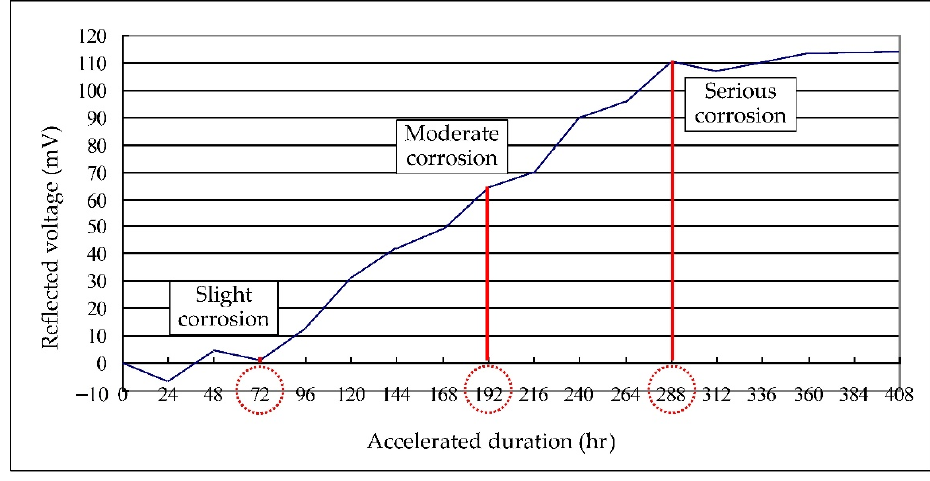
Figure 13. Reflected Voltage of 4 cm Protective Layer.